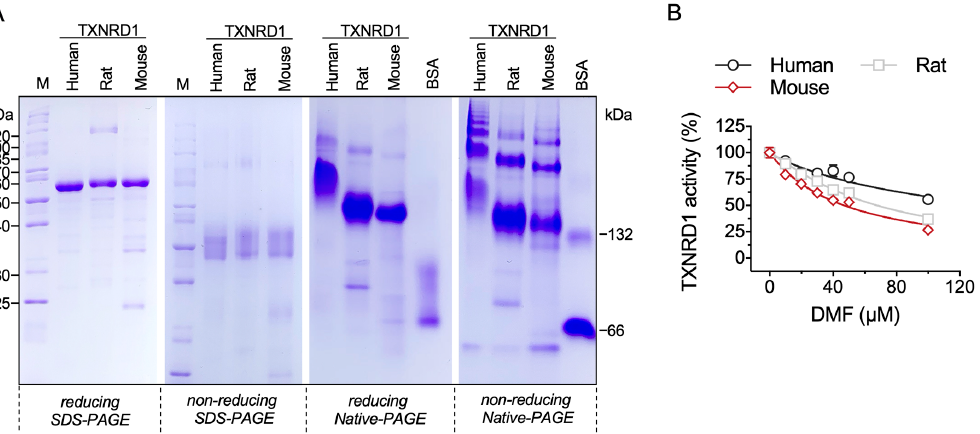
Figure 4. Inhibition of human TXNRD1 by DMF. ( A ) SDS-PAGE and Native-PAGE analysis of human, rat and mouse TXNRD1. ( B ) Inhibition of three species of TXNRD1 by DMF. The final reaction mix contained 40 nM human TXNRD1, 10 nM rat TXNRD1 and 20 nM mouse TXNRD1,